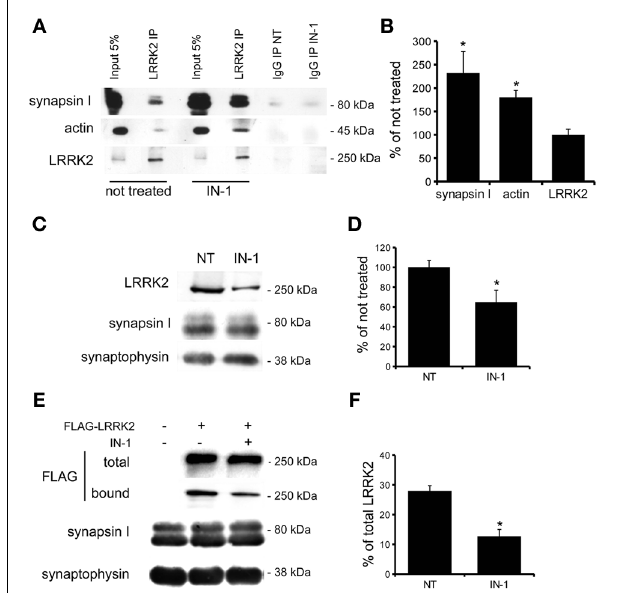
FIGURE 7 | IN-1 modifies LRRK2 binding properties. (A) Extracts of purified cortical synaptosomes were incubated with anti-LRRK2 antibodies or rabbit IgG in absence (not treated) or in presence of IN-1 (IN-1, 1 µ M 2h). The immunocomplexes were sedimented with protein G-Sepharose and the samples were resolved by SDS-PAGE and analyzed by immunoblotting with anti synapsin I, anti actin and anti LRRK2 antibodies. (B) Quantification of IN-1 effect on LRRK2 interaction with synapsin I, actin and LRRK2 itself. Results are calculated as percent of respective controls (not treated sample) and expressed as mean ± s.e.m. ( ∗ P < 0 . 05, n = 4, Student’s t -test vs. not treated sample). (C) purified native synaptic vesicles (SV; 40 µ g/sample) were incubated in the absence (NT) or presence of IN-1 (IN-1, 1 µ M 2h). After incubation, SV were recovered by high speed centrifugation and the residual amounts of endogenous LRRK2 bound to SV were determined by immunoblotting with anti-LRRK2 antibodies. The recovery of SV in the pellet was evaluated based on synaptophysin immunoreactivity. (D) LRRK2 recovery in the SV pellet was calculated as the percentage of the not treated sample and shown as mean ± s.e.m. ( ∗ P < 0 . 05, n = 8, Student’s t -test vs. relative control). (E) Purified FLAG-LRRK2 was incubated with SV (10 µ g protein/sample) in presence or absence (NT) of IN-1 (IN-1, 1 µ M 2h). SV-bound FLAG-LRRK2 was separated from free FLAG-LRRK2 by high-speed centrifugation and quantified by immunoblotting with anti-FLAG antibody. The recovery of SV in the pellet was evaluated based on synaptophysin immunoreactivity. (F) The binding of FLAG-LRRK2 to SV was calculated as the percentage of total FLAG-LRRK2 and expressed as mean ± s.e.m. ∗ p < 0 . 05; Student’s t -test vs. relative